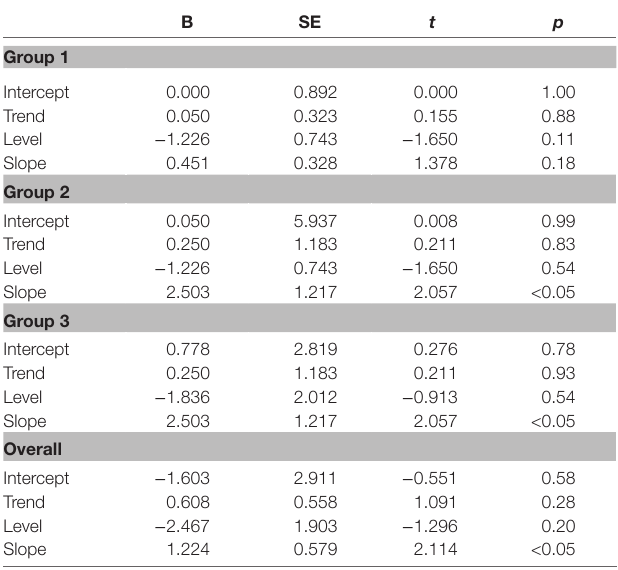
TABLE 10 | Regression model for words read correctly across all participants (level